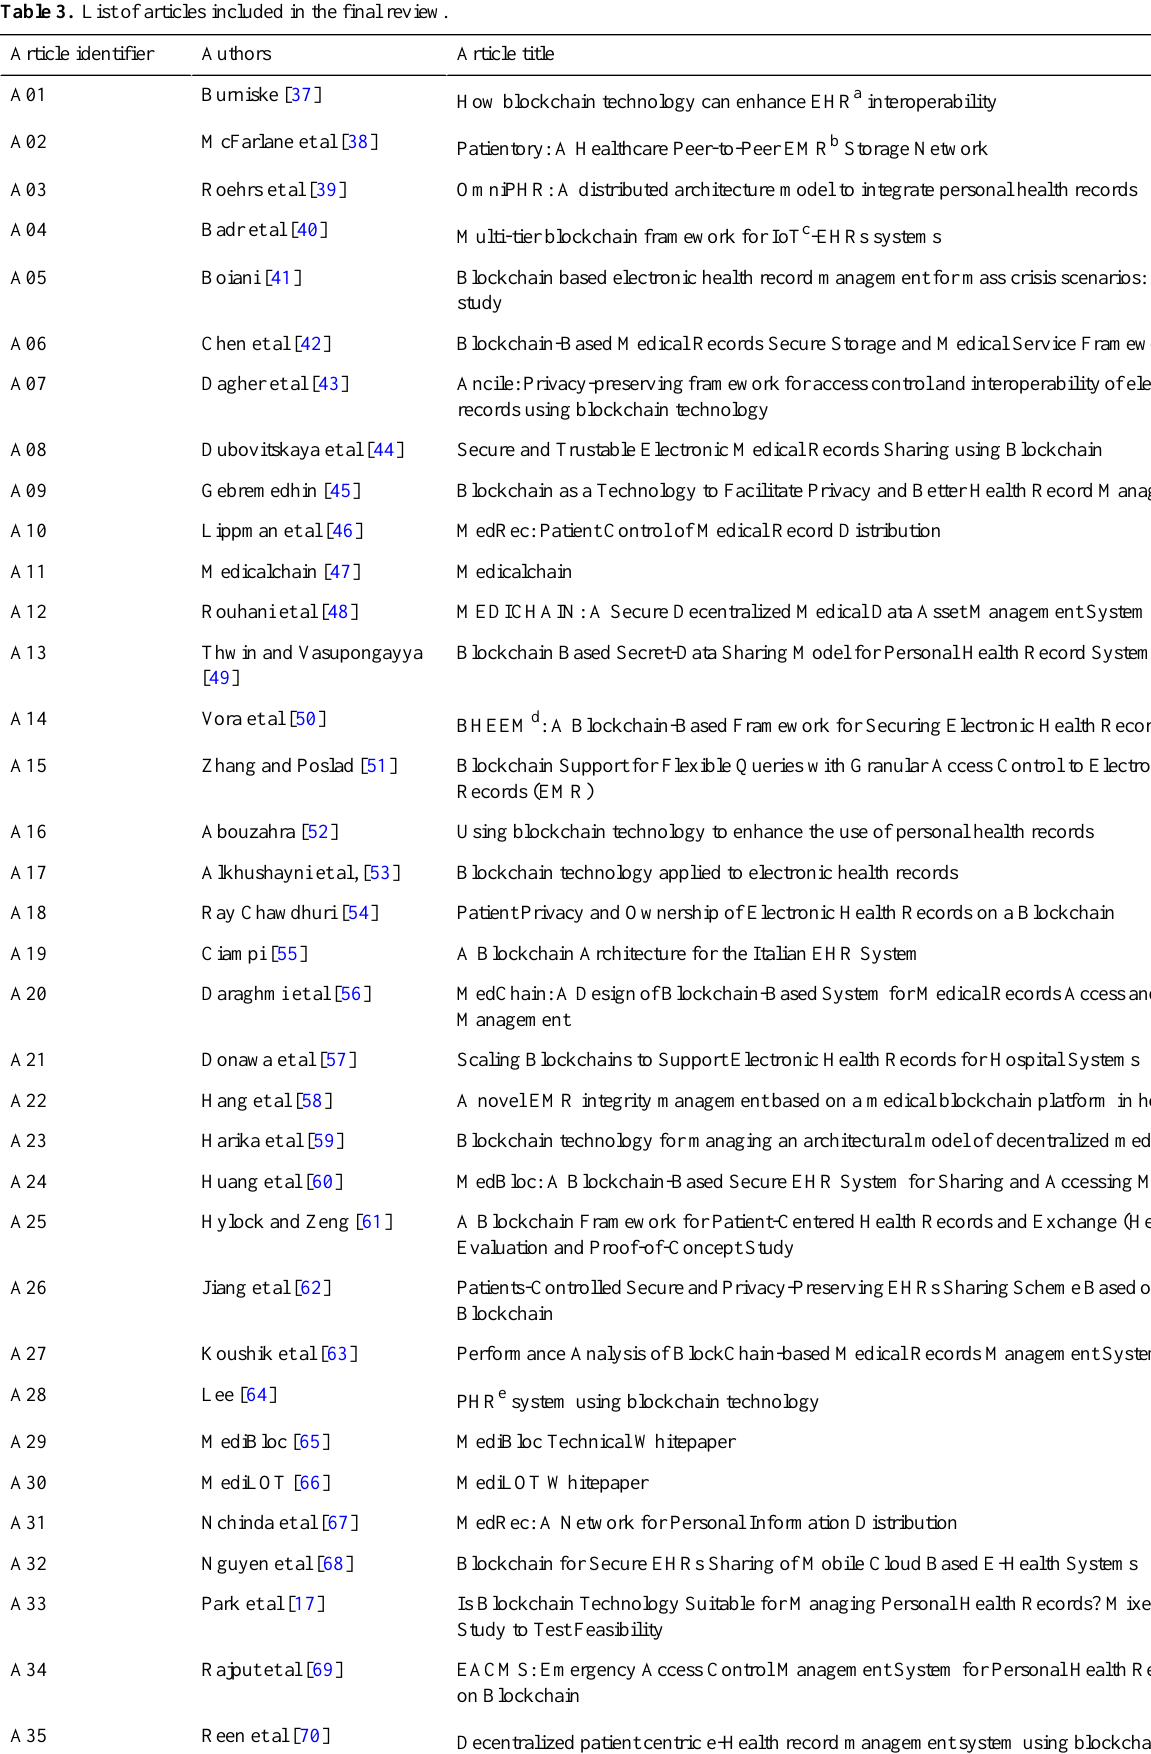
Table 3. List of articles included in the final review.